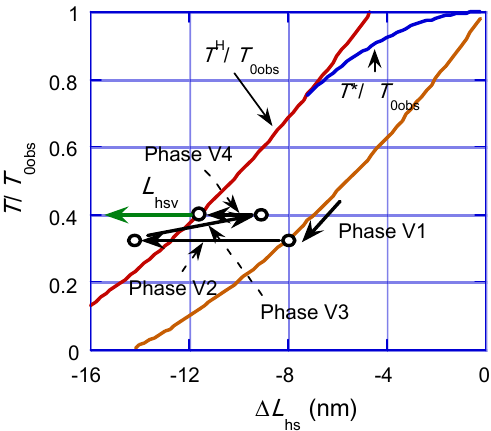
Figure 16. Phases in the isometric tension transient on the T / T black arrows indicate an example of changes of the relevant Phases in the case of > y . Actually the arrows are on the same horizontal lines, except for the case of  y cV1 cdev Phase